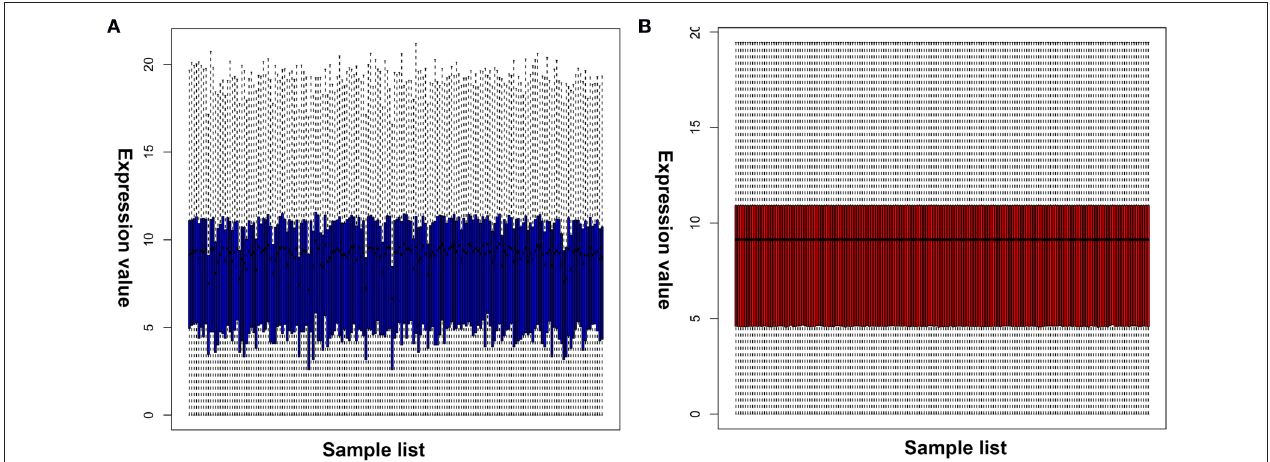
FIGURE 4 | Normalization of TCGA data. (A) Data before normalization; (B) data after normalization.